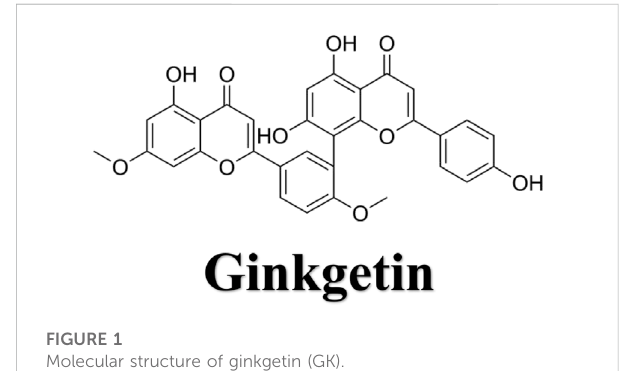
FIGURE 1 Molecular structure of ginkgetin